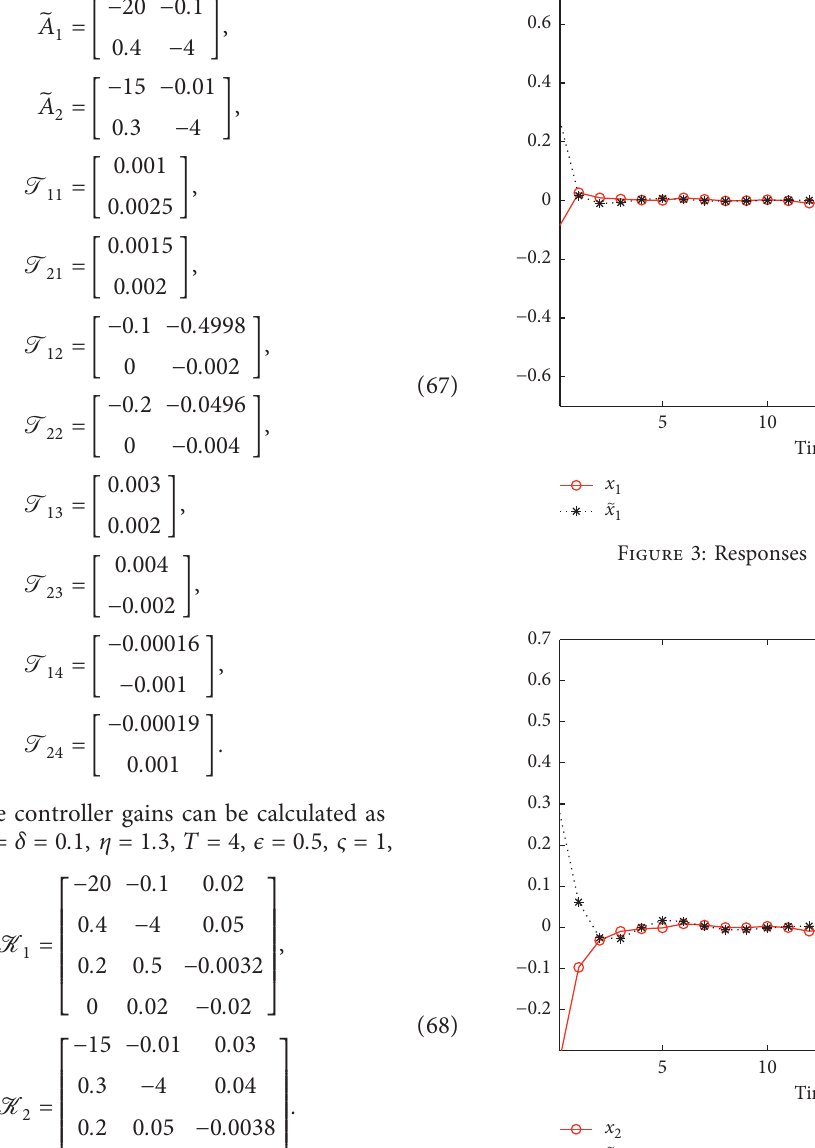
Figure 4: Responses of x